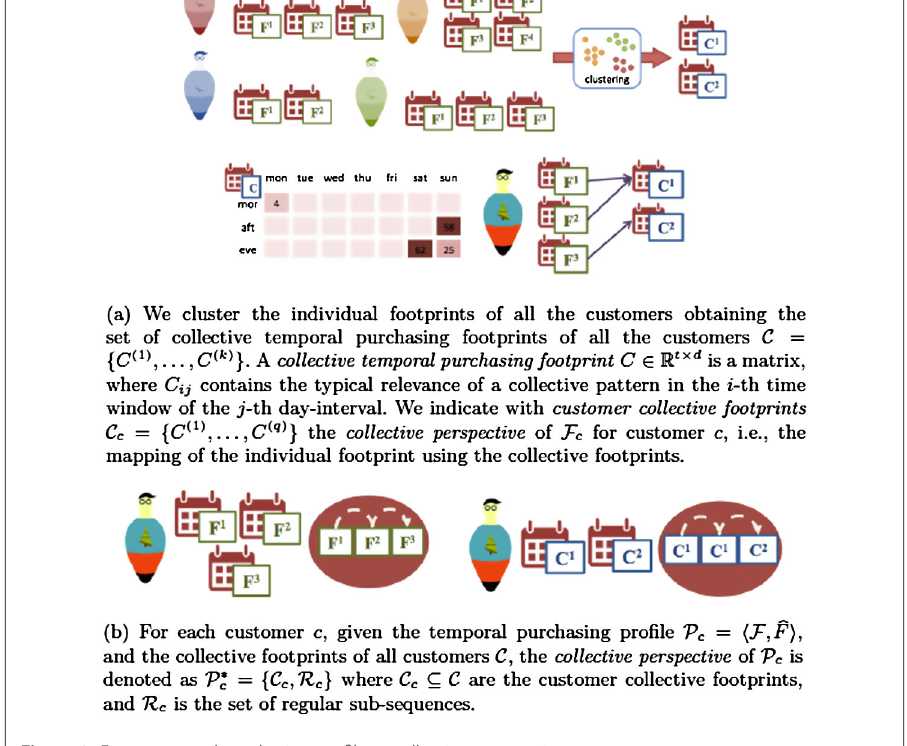
Figure 3 From temporal purchasing profile to collective